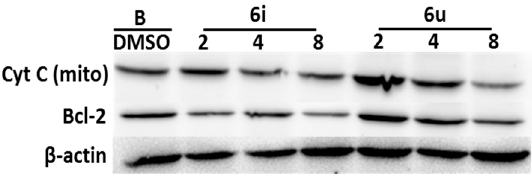
Figure 4. Western blot analysis of cytochrome C and bcl-2 proteins. A549 cells were treated with with 6i and 6u at 2, 4, and 8 μ M for 48 h. β -actin was used as an internal control.